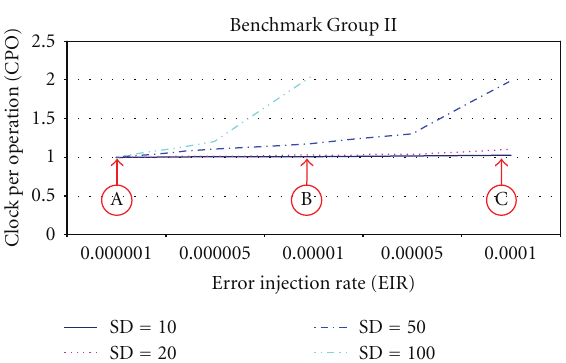
Figure 26: Simulation Curves for Group